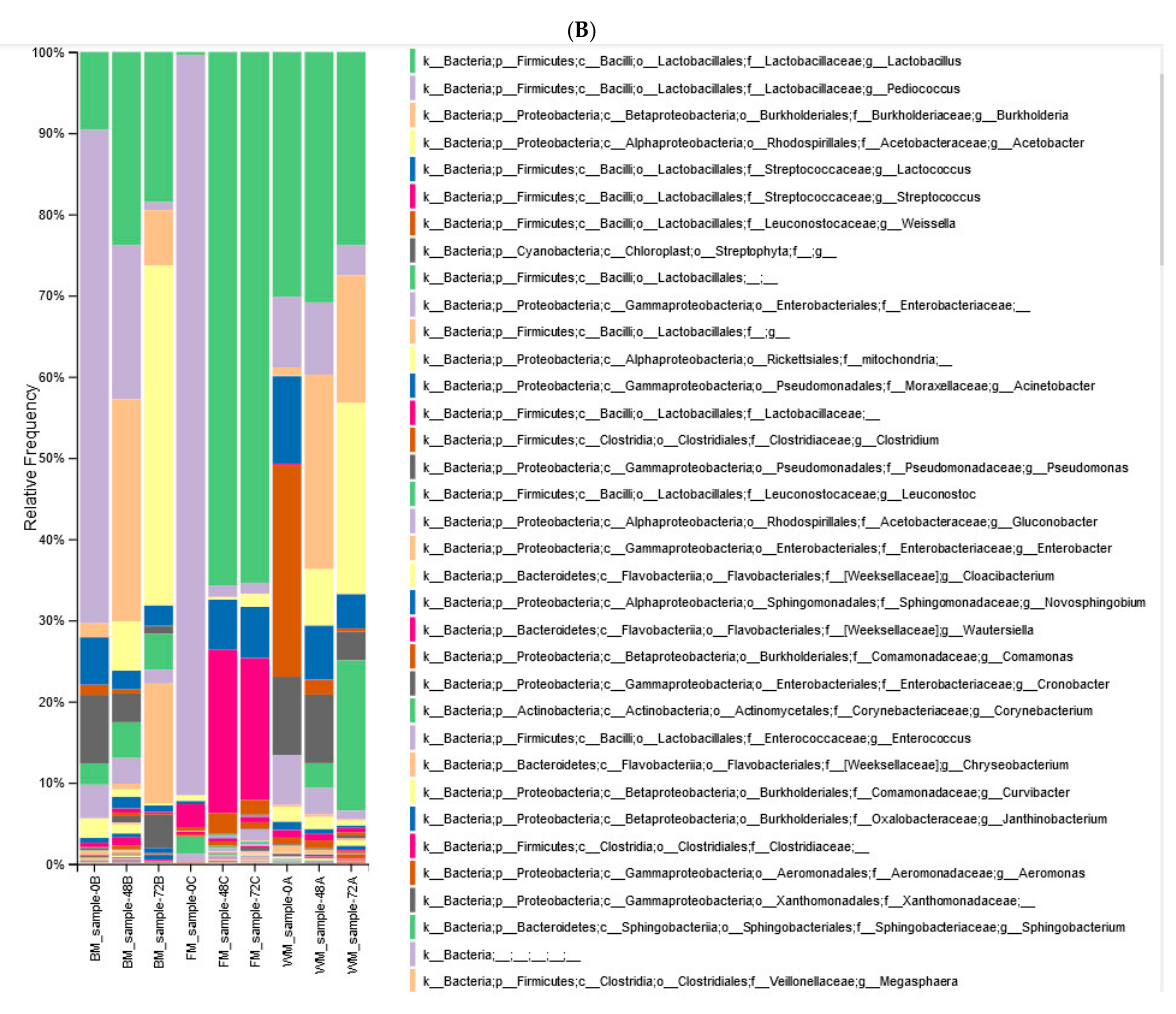
Figure 1. Bacterial diversity during millet beverage fermentation. Alpha diversity data were visual- ized at different taxonomic levels. ( A ) Kunu, three fermentations were conducted at different time points and the data shown are for 0 h and 72 h timepoints [29] and ( B ) Ogi fermentations of brown millet (BM) fonio millet (FM), and white millet (WM) [32]. The data shown are for the 0 h, 48 h, and 72 h time points. Differences are observed at the family and genus levels.